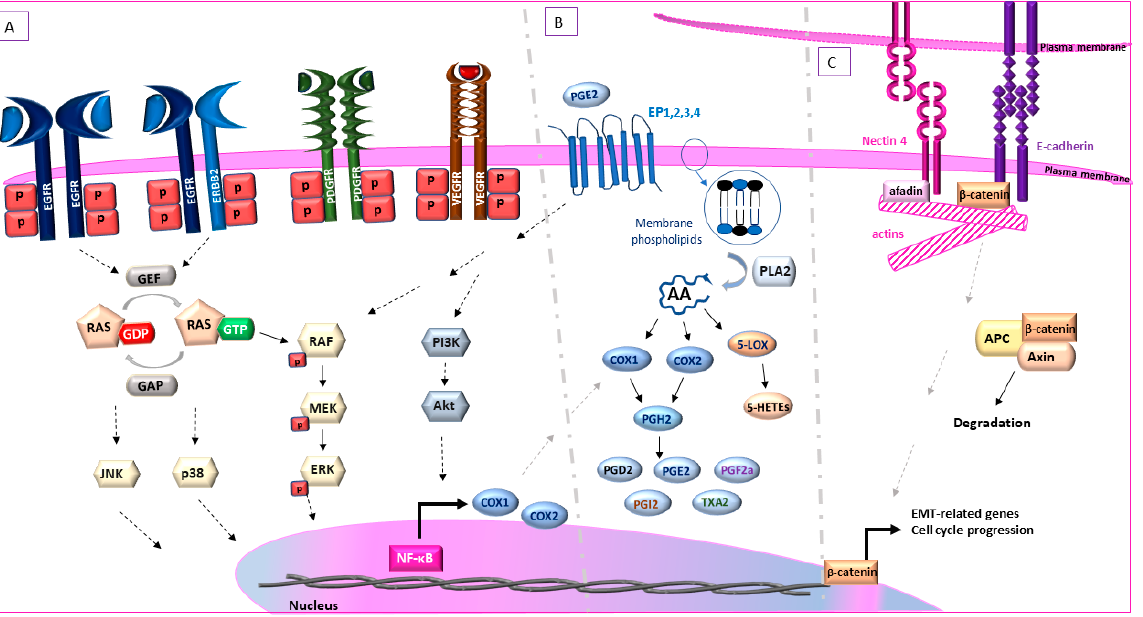
Figure 3. Fundamental signaling pathways governing canine UC. ( A ). Extracellular stimuli bind to membranous tyrosine kinase receptors such as PDGFR, VEGFR and the ErbB family, causing a phosphorylation cascade of the receptors’ tyrosine residues, leading to the activation of RAS-GTPase by GEF and subsequently the activation of RAF family of proteins. MEK is then phosphorylated by RAF which in turn phosphorylates and activates ERK. ( B ). PLA2 converts membrane phospholipids to AA. COX-1 and COX-2 convert AA to PGH2, which is a substrate for the synthesis of PGE 2 , PGD 2 PGF 2a , PGI 2 and TXA 2 . 5-, 8-, 12- and 15- LOX convert A to 5-, 8-, 12- and 15-HETEs respectively. ( C ). Nectins are connected to actin cytoskeleton through the protein afadin. The extracellular domains of e-cadherins interact with the corresponding extracellular domains of E-cadherin molecules of adjacent cells, forming a “zipper”-like structure. The cytoplasmic domain of e-cadherin is indirectly associated with the cytoskeleton through binding to β -catenin. In the absence of Wnt signaling, β -catenin is ubiquitinated and degraded after forming a protein complex with adenomatous polyposis coli (APC) and axin. EGFR = endothelial growth factor receptor, ErbB2 = erythroblastic oncogene B 2, PDGFR = platelet-derived growth factor receptor, VEGFR = vascular endothelial growth factor receptor, NF- κ B = nuclear factor kappa B, EP2 = prostaglandin E2 receptor 2, PG: prostaglandin, COX = cyclooxygenase, TXA2 = thromboxane A2, PI3K = phosphatidylinositol-3-kinase, Akt = protein kinase B, AA = arachidonic acid, GEF = guanine nucleotide exchange factor, GAP = GTP-ase activating protein, GTP = guanosine-5-triphosphate, GDP =